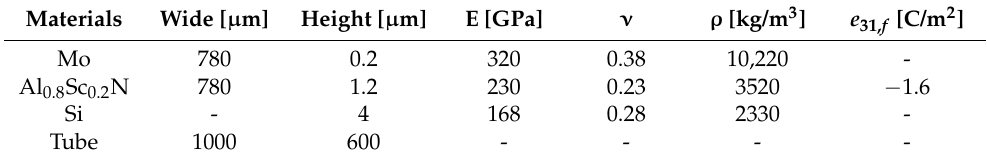
Table 1. PMUT material